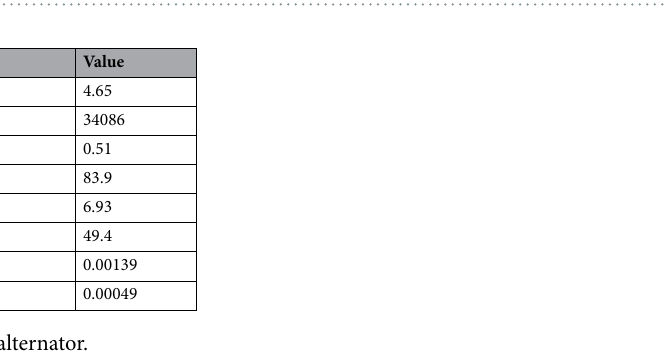
Figure 6. Photos of main components: ( a ) thermoacoustic stage, ( b ) ambient heat exchanger, ( c ) hot heat exchanger.